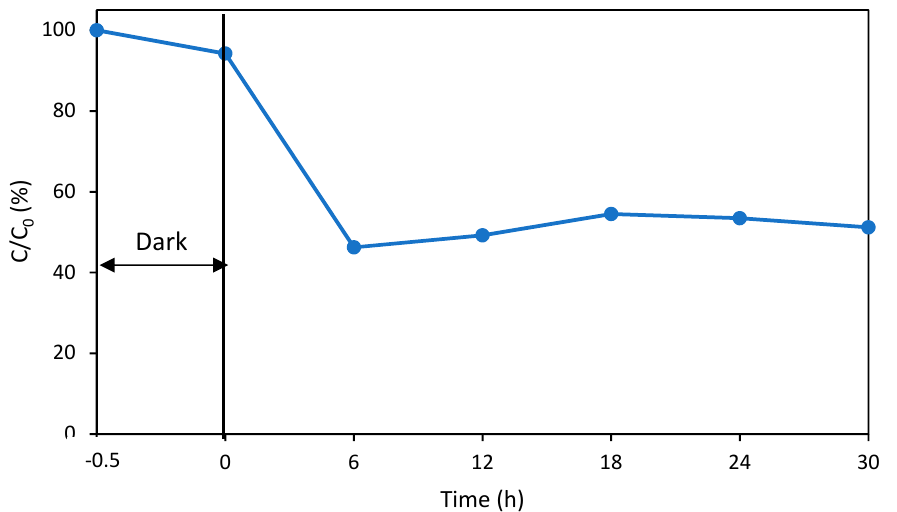
Figure 4. Stability of photocatalytic system with EtOH–C 6 H 5 Cl as solvent for coating under flow method conditions (flow rate 0.350 mL/min).